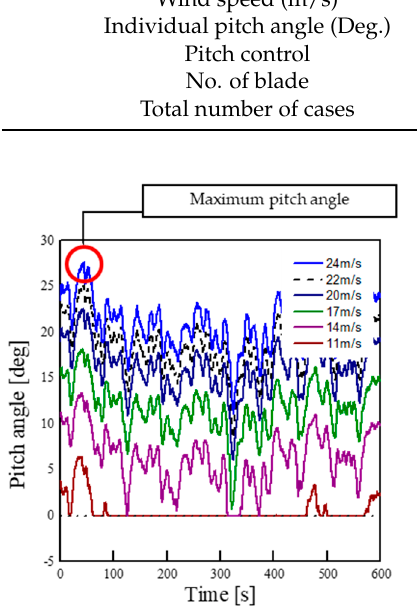
Figure 2. Pitch angle with wind speed histories.